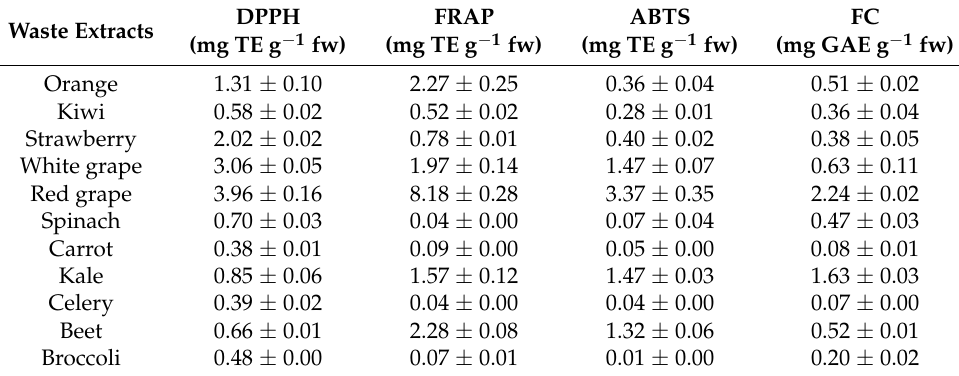
Table 3. Comparison of TPC and antioxidant activity of different fruit and vegetable extracts. Data are expressed as mean ± standard derivation ( n =